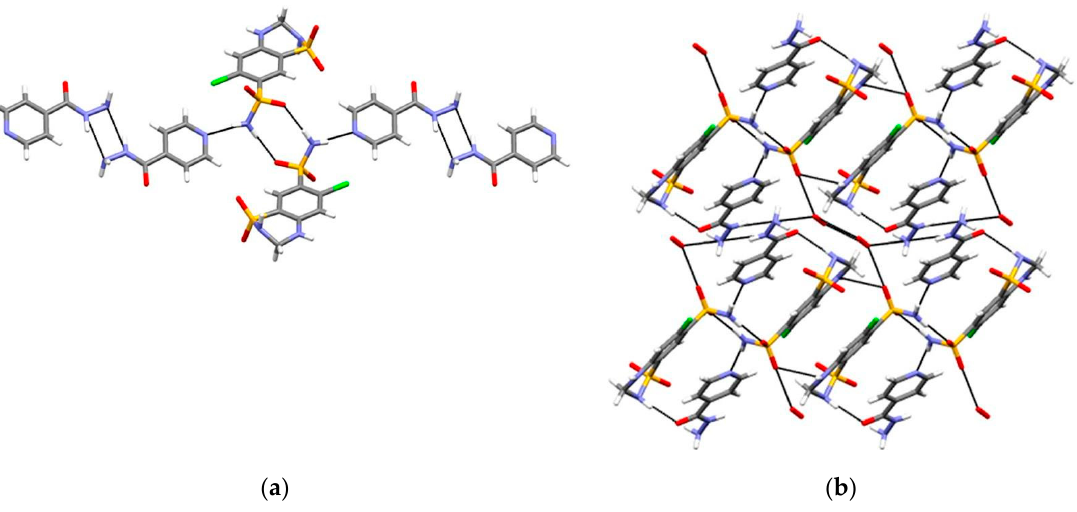
Figure 31. ( a ) Homodimer synthons of HCT and INZ. ( b ) 3D supramolecular structure of HCT-INZ-H 2 O. Adapted with permission from Crystal Growth & Design , 2017, 17, 308–316. Copyright 2017, American Chemical Society.